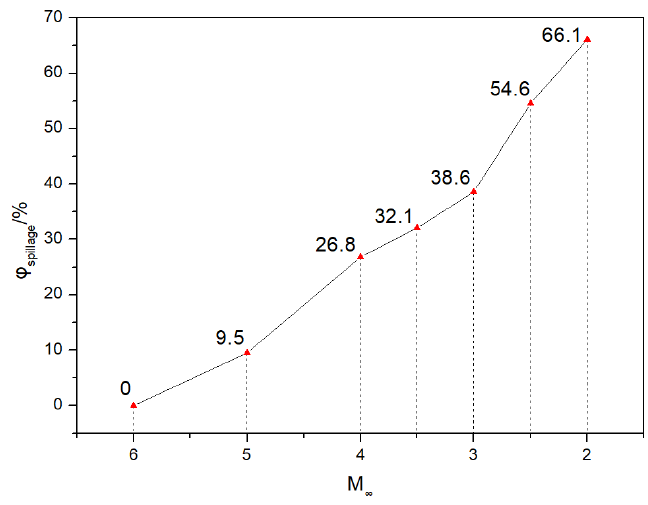
Figure 14. Impact of different Mach numbers to φ spillage.